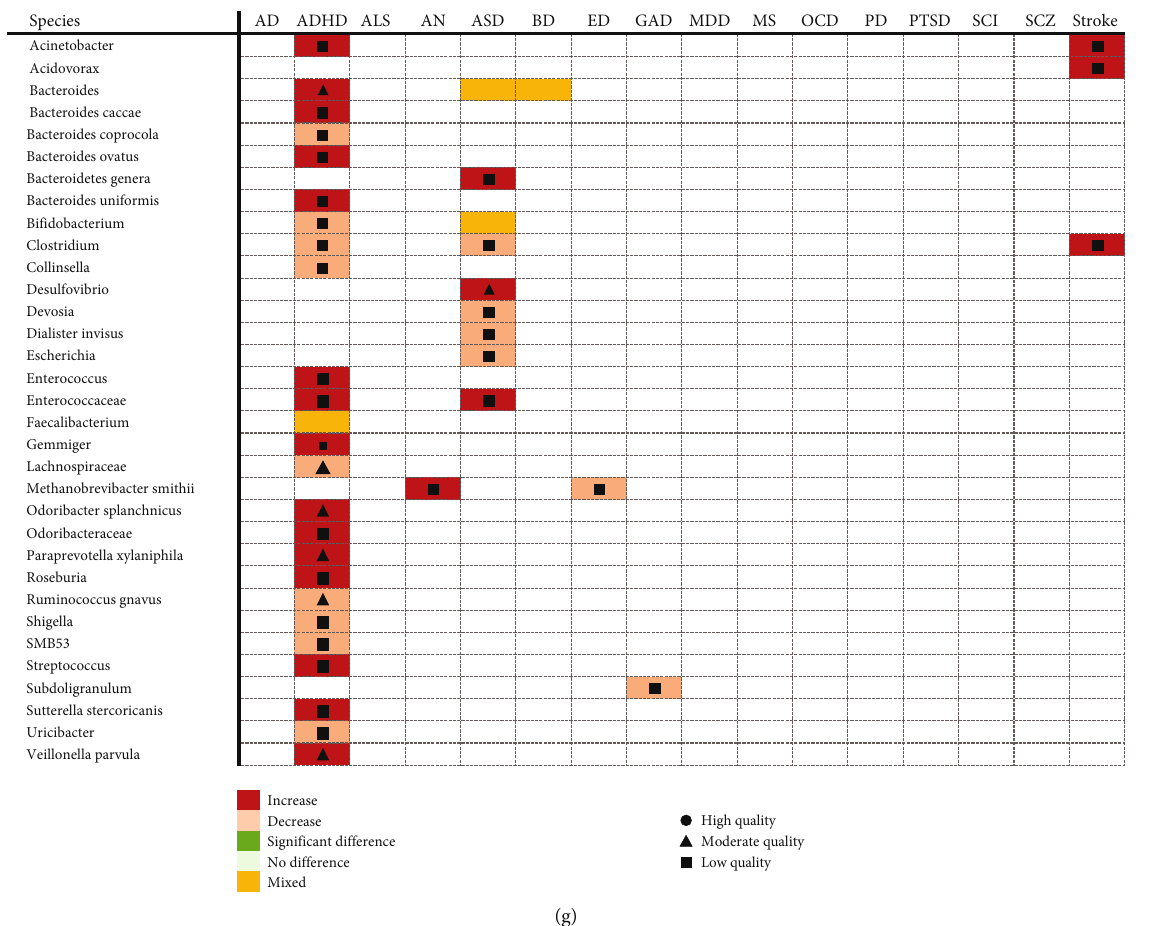
Figure 3: Evidence mapping of microbiome changes. Abbreviations: AD: Alzheimer ’ s disease, ADHD: attention de fi cit hyperactivity disorder, ALS: amyotrophic lateral sclerosis, ASD: autism spectrum disorder, AN: anorexia nervosa, BD: bipolar disorder, ED: eating disorder; GAD: generalized anxiety disorder, MDD: major depressive disorder, MS: multiple sclerosis, OCD: obsessive compulsive disorder, PD: Parkinson ’ s disease, PTSD: posttraumatic stress disorder, SCI: spinal cord injury, SCZ: schizophrenia. (a) Diversity. (b) Phylum level. (c) Class level. (d) Order level. (e) Family level. (f) Genus level. (g) Species